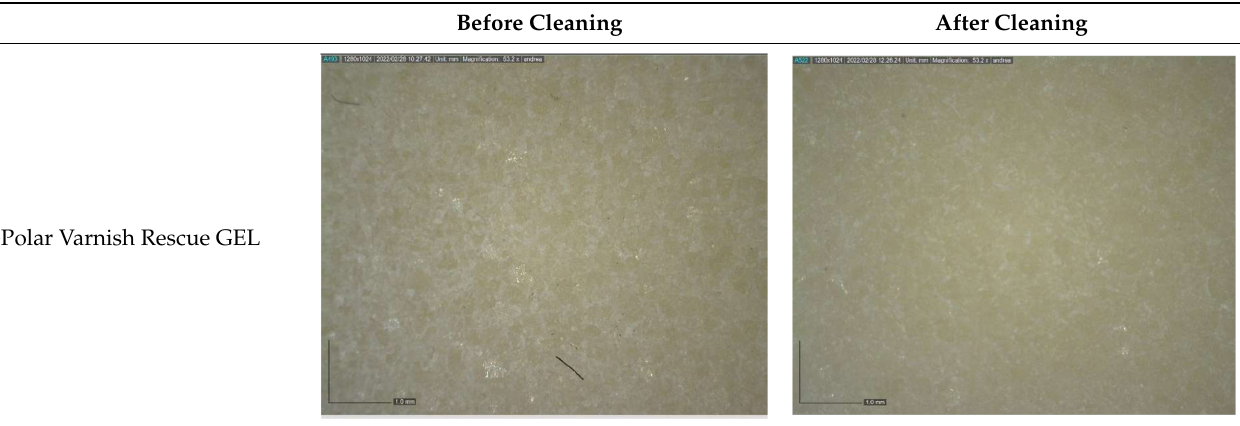
Figure 8. Photographs of the surfaces after treatment.